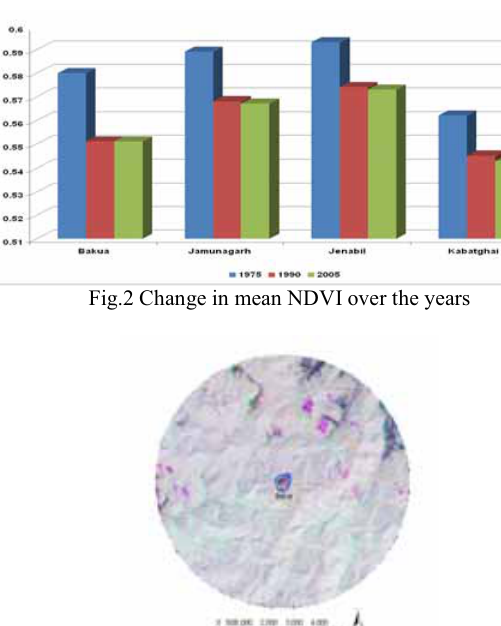
Fig. 1 LISS IV image showing the location of the villages in the core zone of SBR